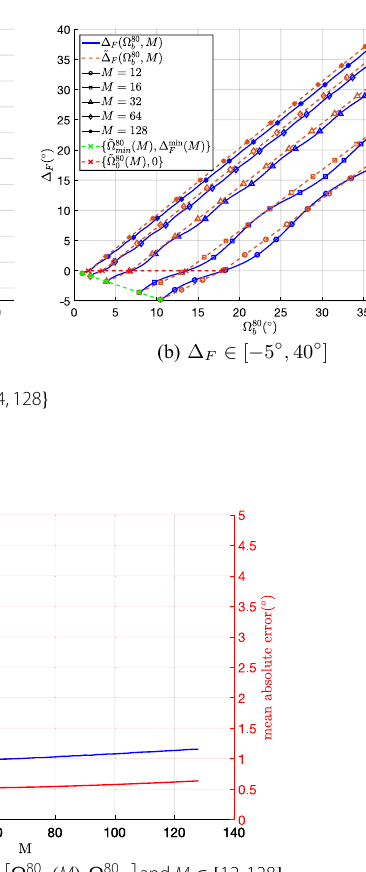
Fig. 11 Mean relative and absolute error for � 80 b